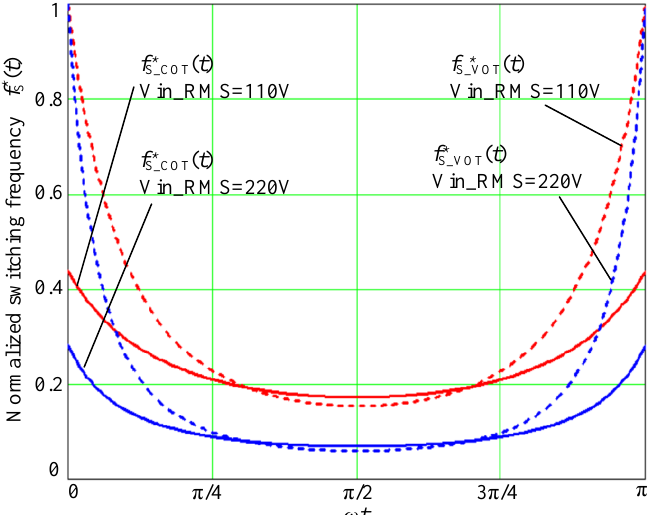
Figure 9. Comparison of the normalized switching frequency curves with COT and VOT control schemes during half AC line period .